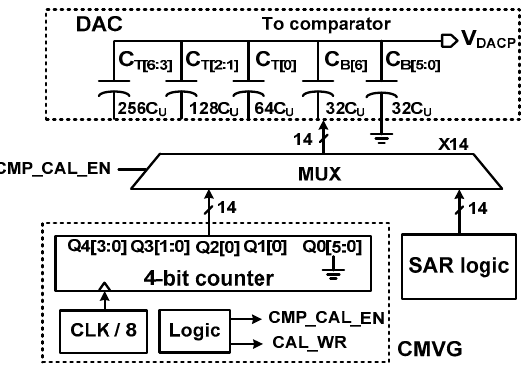
Figure 5. Block diagram of the common-mode voltage generator.